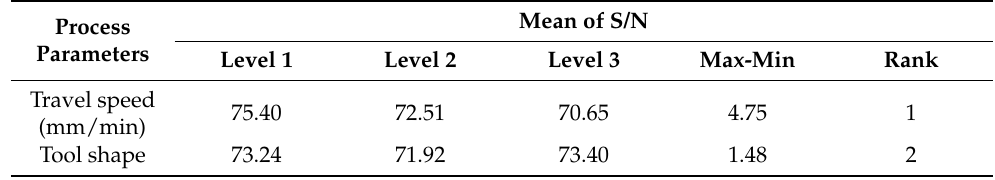
Table 6. Mean S/N ratio response table for TSL. Figure 8. Contour plot for Tw against travel speed and tool shape.